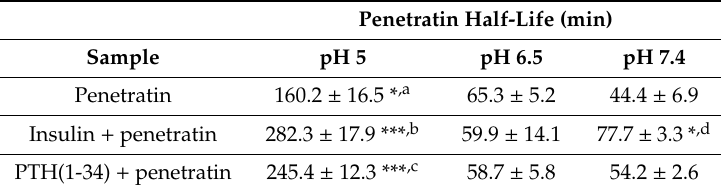
Table 1. Penetratin half-life determined after incubation of 25 µ M penetratin or 20 µ M penetratin co-administered with 5 µ M insulin or PTH(1-34) on the apical side of Caco-2 monolayers for 4 h (N = 3, mean ± SD).